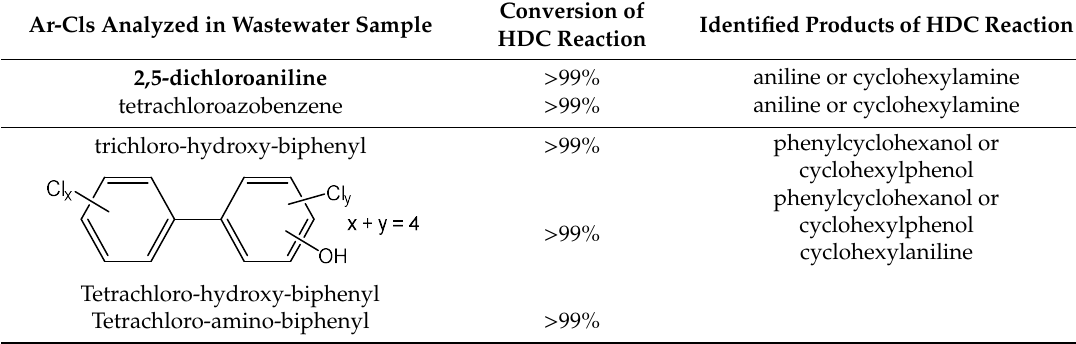
Table 6. Results of Ar-Cls contaminants HDC in wastewater obtained from production of azo pigments using Al-Ni / NaOH + NaBH 4 . The experimental procedure is described in Section 4.2.5. For more details see Supplementary Materials, Figure S6.